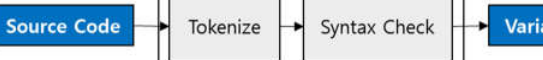
Figure 2. Static Analysis